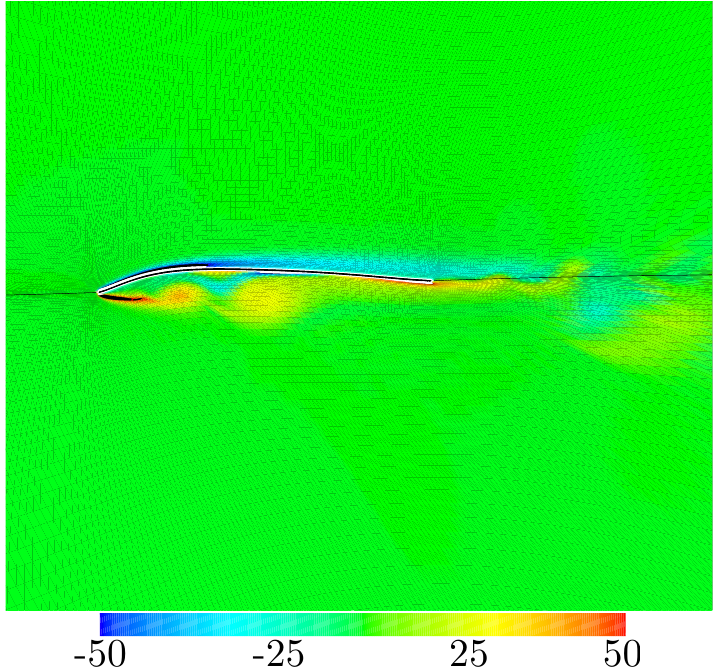
Figure 19. Distribution of vorticity around the optimal airfoil at Re = 4000, α = − 2 ◦ , and dimensionless time t ∗ =